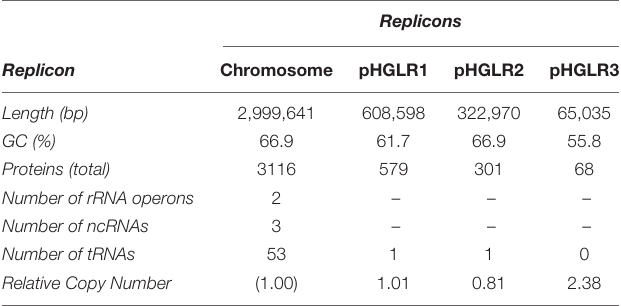
TABLE 1 | Replicons of Hfx. gibbonsii